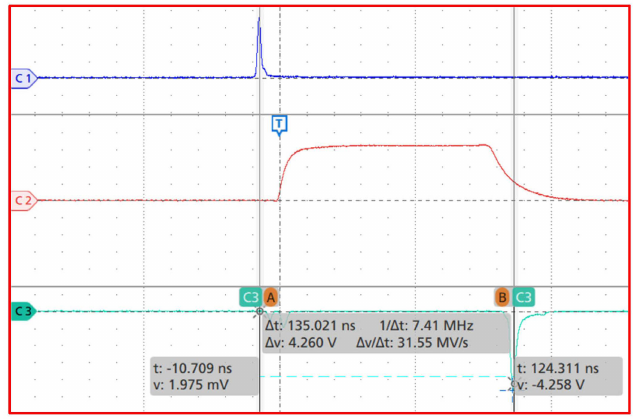
Figure 25. The waveform from the experiment under the artificial water